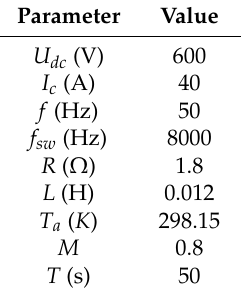
Table 5. Simulation